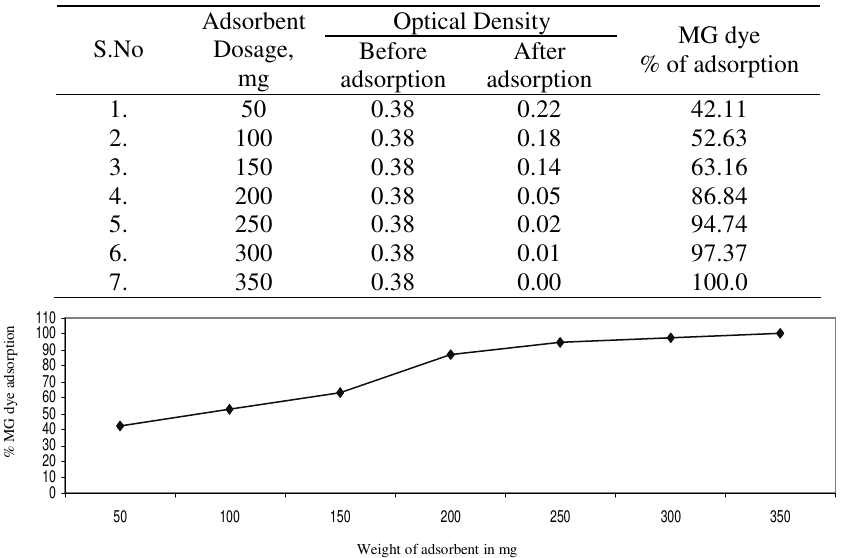
Figure 2. Effect of adsorbent dosage on removal of MG dye